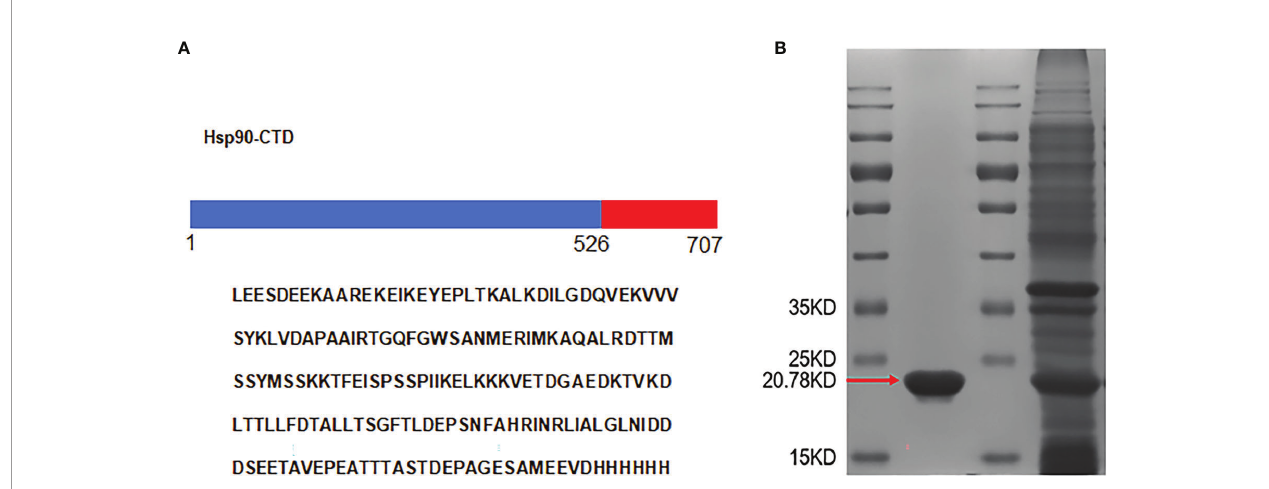
FIGURE 1 | Design and expression of antigen. (A) The amino acid sequences of the recombinant protein Hsp90-CTD. (B) The His-tagged recombinant proteins were puri fi ed by Ni-af fi nity chromatography and analyzed by SDS-PAGE. Red arrow shows monomers of Hsp90-CTD. The other band was from the supernatant that contained soluble